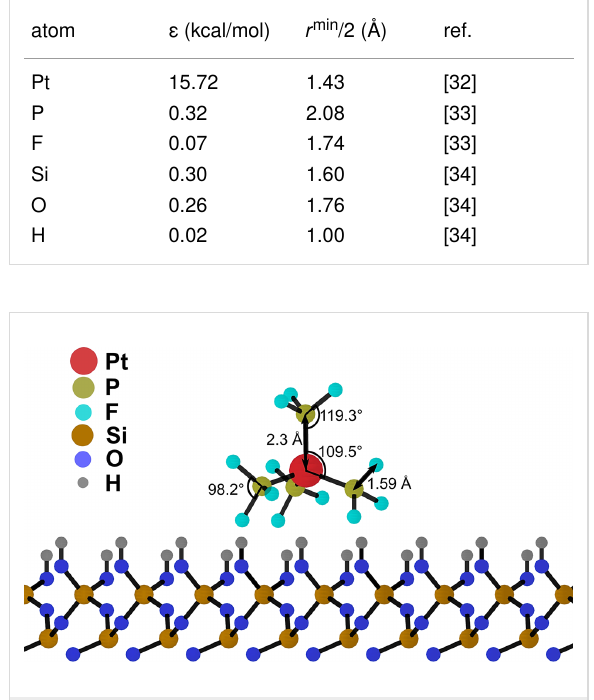
Figure 2: Side view of an optimized single Pt(PF 3 ) 4 molecule adsorbed on a SiO 2 -H substrate. The energy minimization calculation is performed using the interatomic potentials from Equations